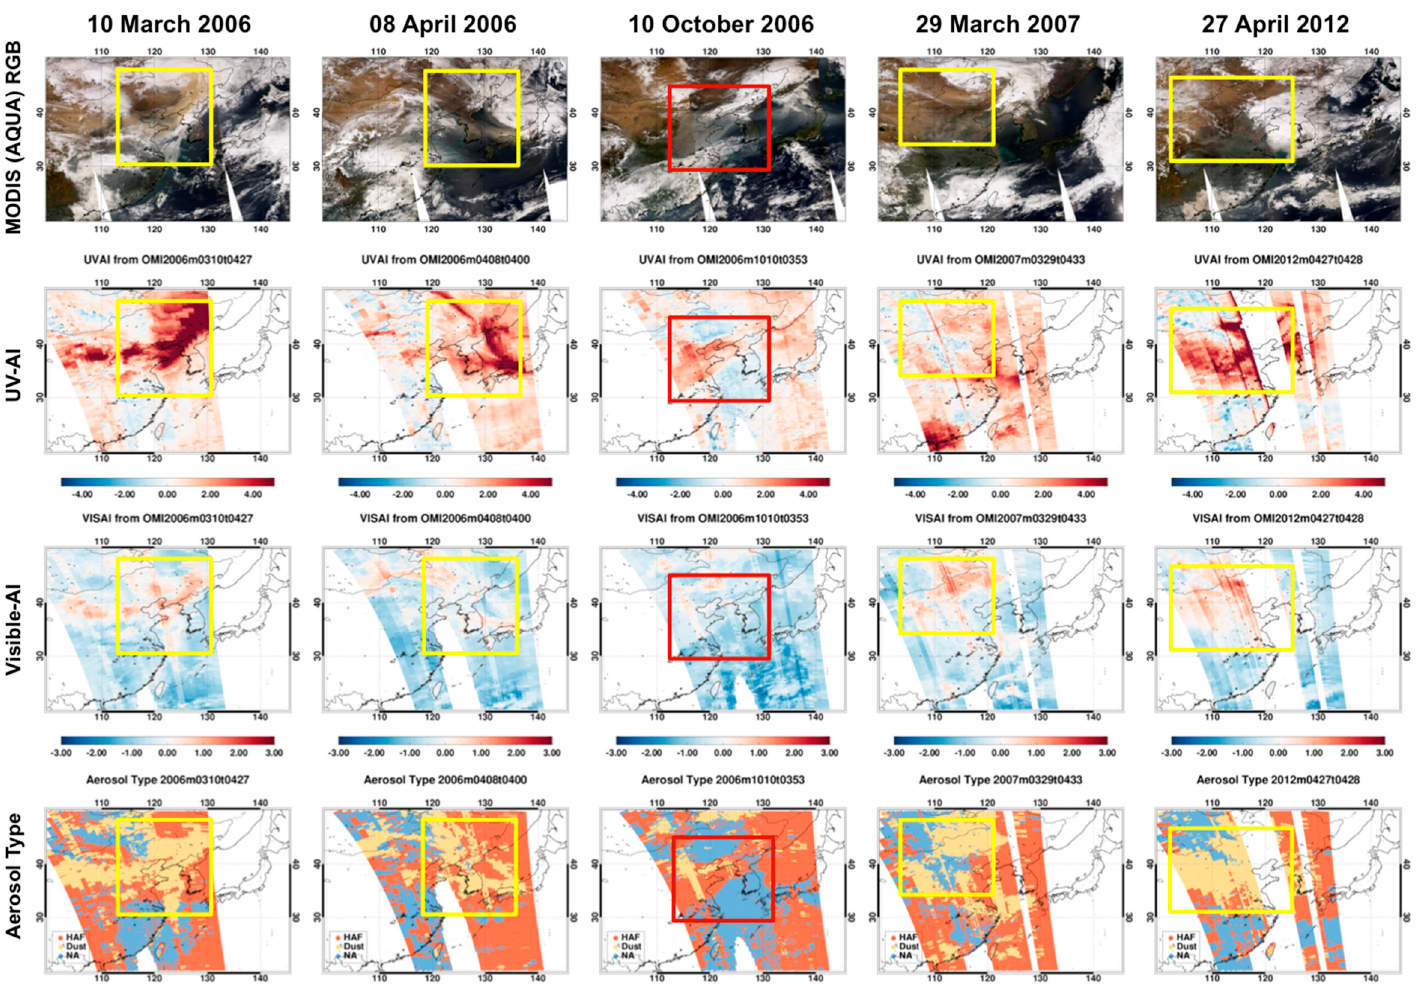
Figure 5. RGB images observed from MODIS (Aqua), UVAI, visible AI and aerosol type calculated from OMI measurement on 10 March 2006, 8 April 2006, 10 October 2006, 29 March 2007 and 27 April 2012. Yellow and red boxes indicate dust and HAF scenarios, respectively.